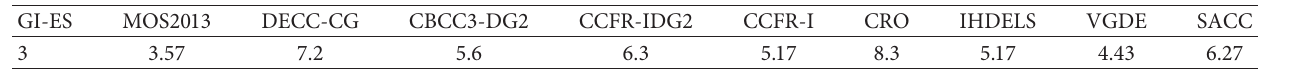
Table 11: Ranking of GI-ES and state-of-the-art algorithms according to Friedman test using CEC2013. GI-ES